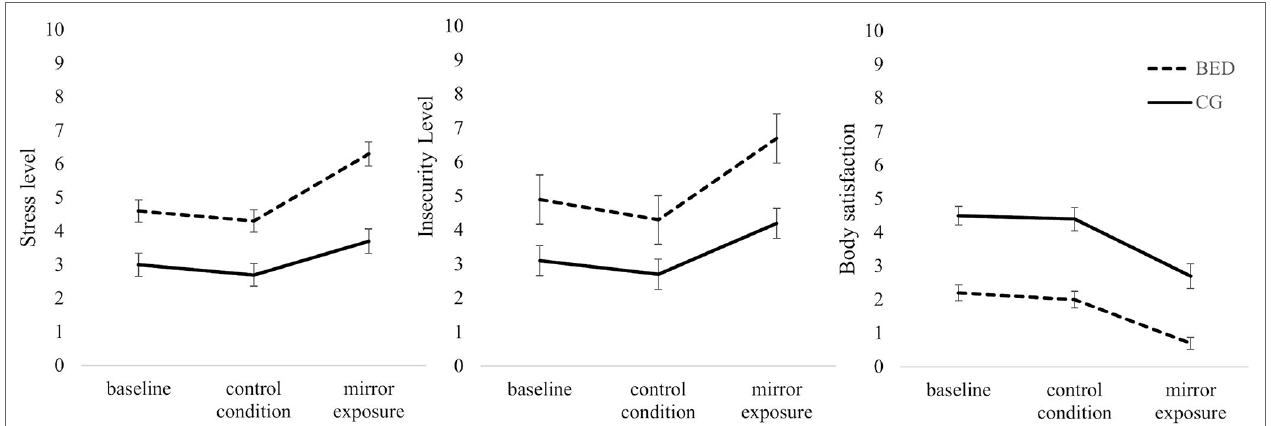
FIgURE 3 | Mean and standard error for self-reported levels of stress, insecurity and body satisfaction at the beginning of the experiment (baseline) and after the control and mirror exposure condition in women with binge eating disorder (BED) and women with overweight and obesity (CG). (Order of the two experimental conditions was counterbalanced between groups. Therefore, the figure presented does not display time sequence).